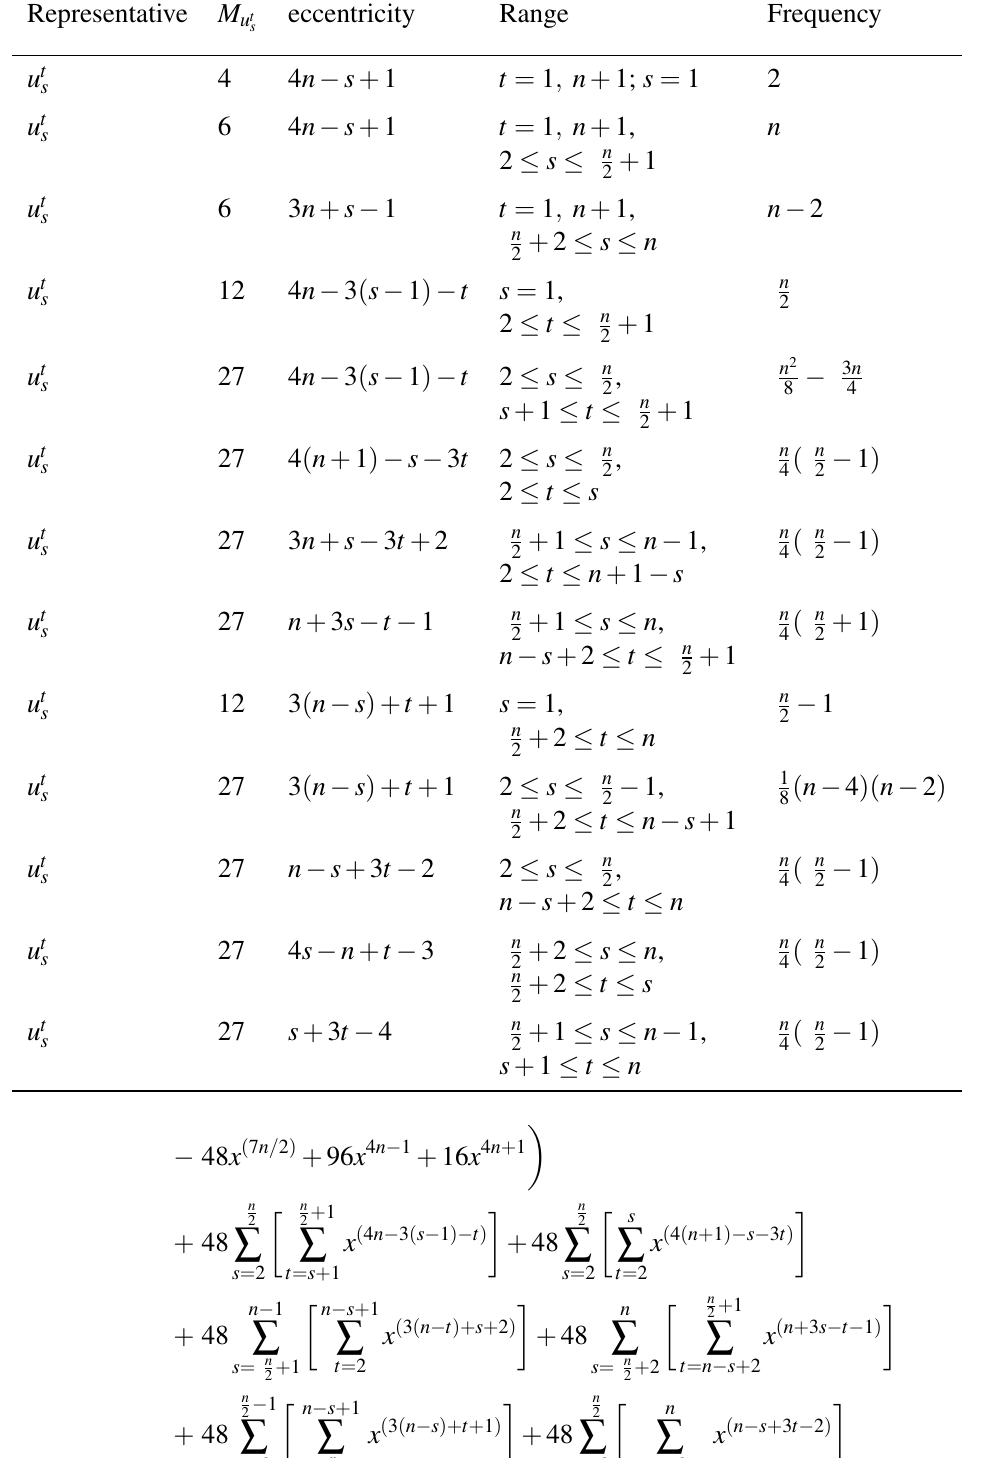
Table 3 Partition of vertices of the type u t mod 2 )